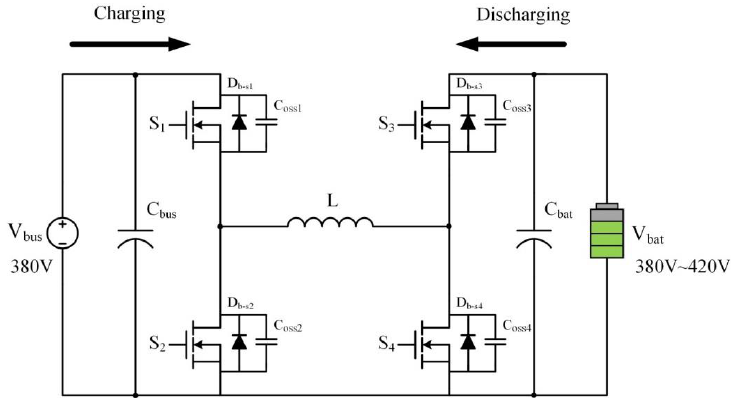
Figure 1. Circuit diagram of the universal bidirectional DC-DC converter.